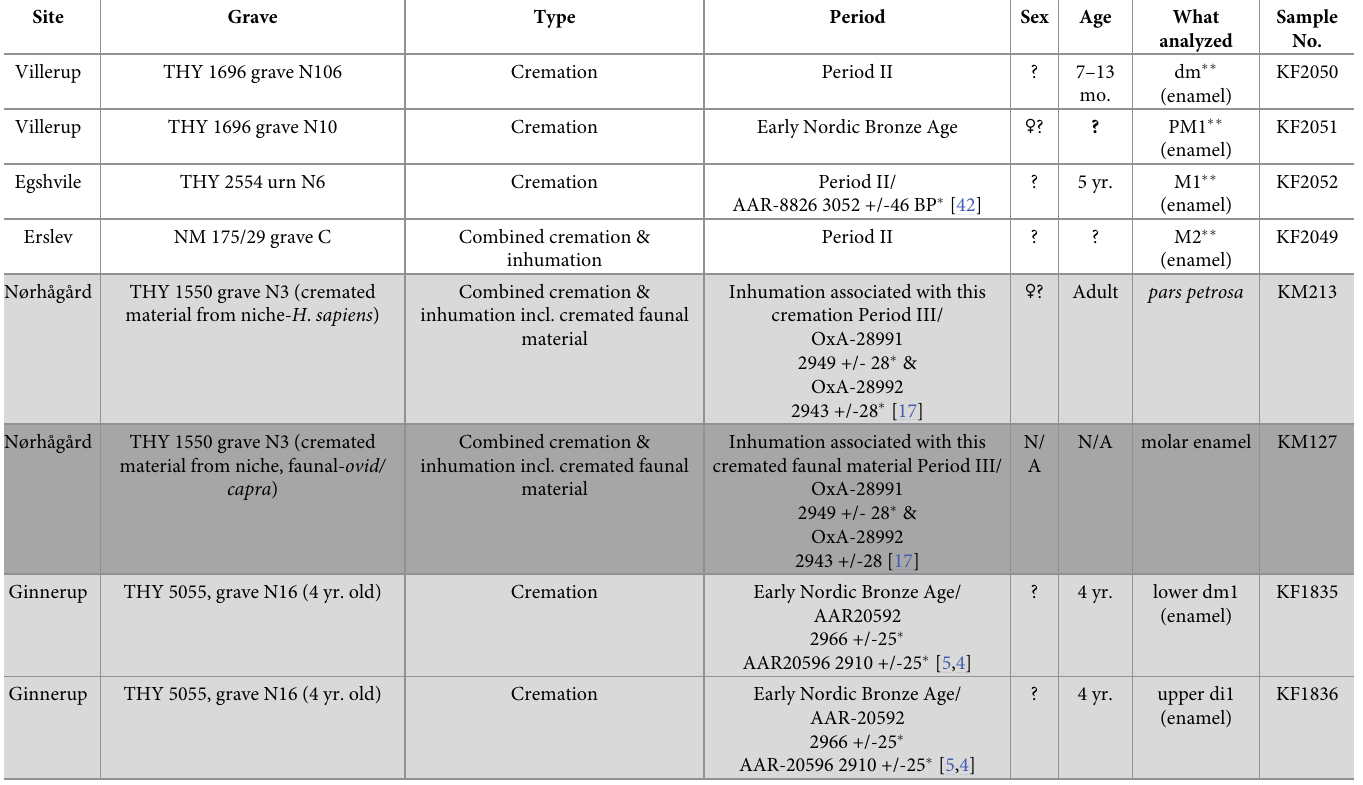
Table 2. Details of material sampled from Early Nordic Bronze Age Thisted County.